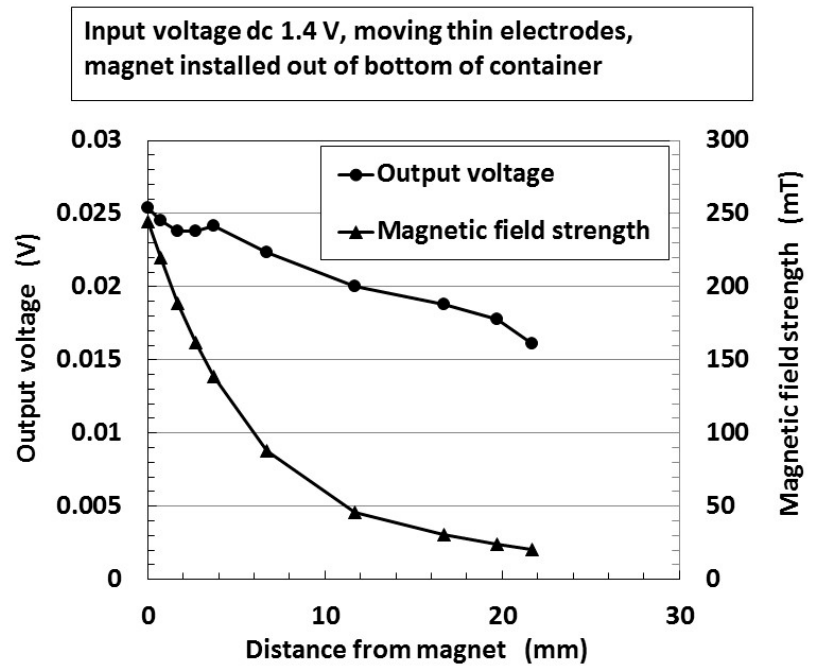
Figure 17. Output voltage and distance of container for moving electrodes with installation of a magnet at the bottom of the outer wall of the container and the application of dc 1.4 V of input voltage.